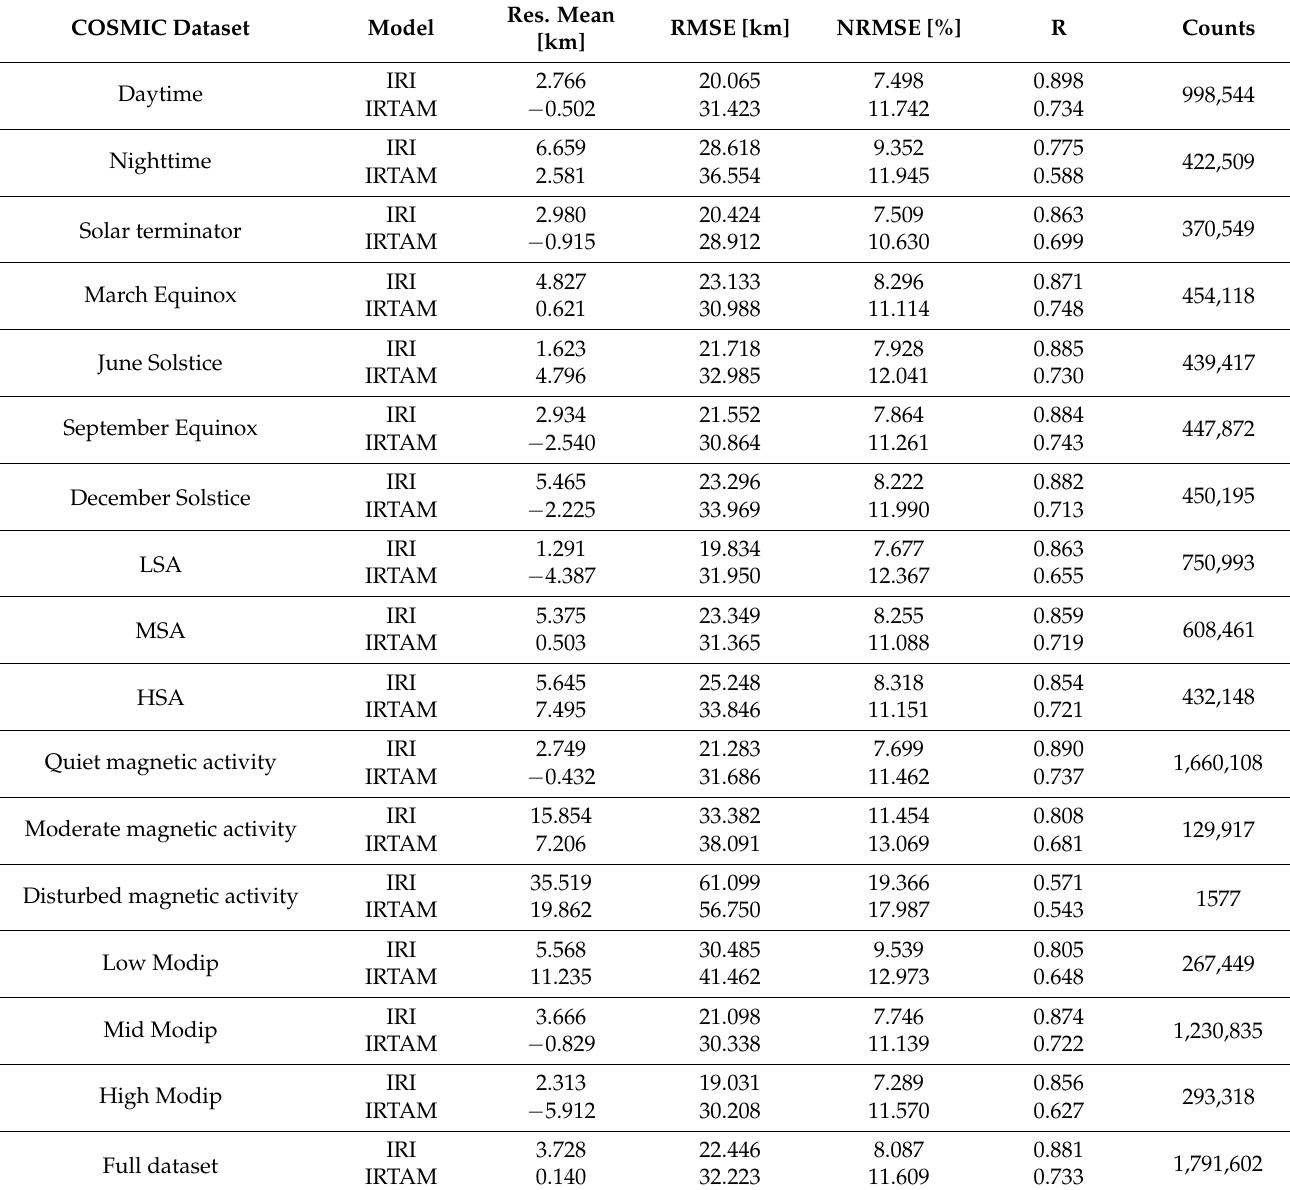
Table 7. Res. Mean, RMSE , NRMSE , and R values calculated for the IRI and IRTAM models on the basis of the hm F2 COSMIC observations, for the bins defined in Section 4.2, according to the three levels of solar activity defined in Section 3.1, and for the full dataset (bottom row). The number of counts on which the statistics were calculated is reported in the rightmost